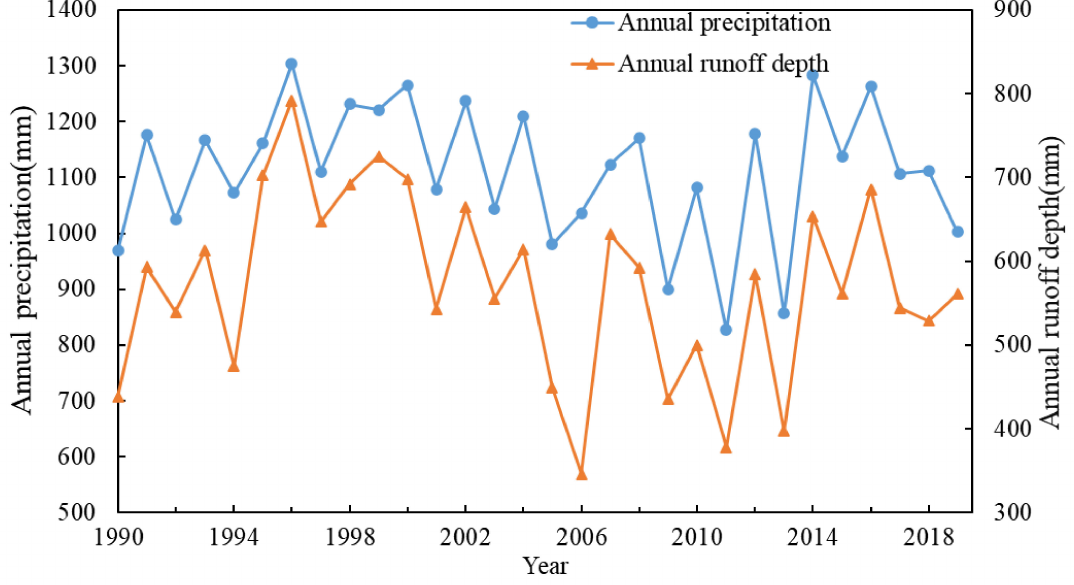
Figure 2. Precipitation and runoff depth inter-annual variation trends in the Wujiang River Basin from 1990 to 2019.